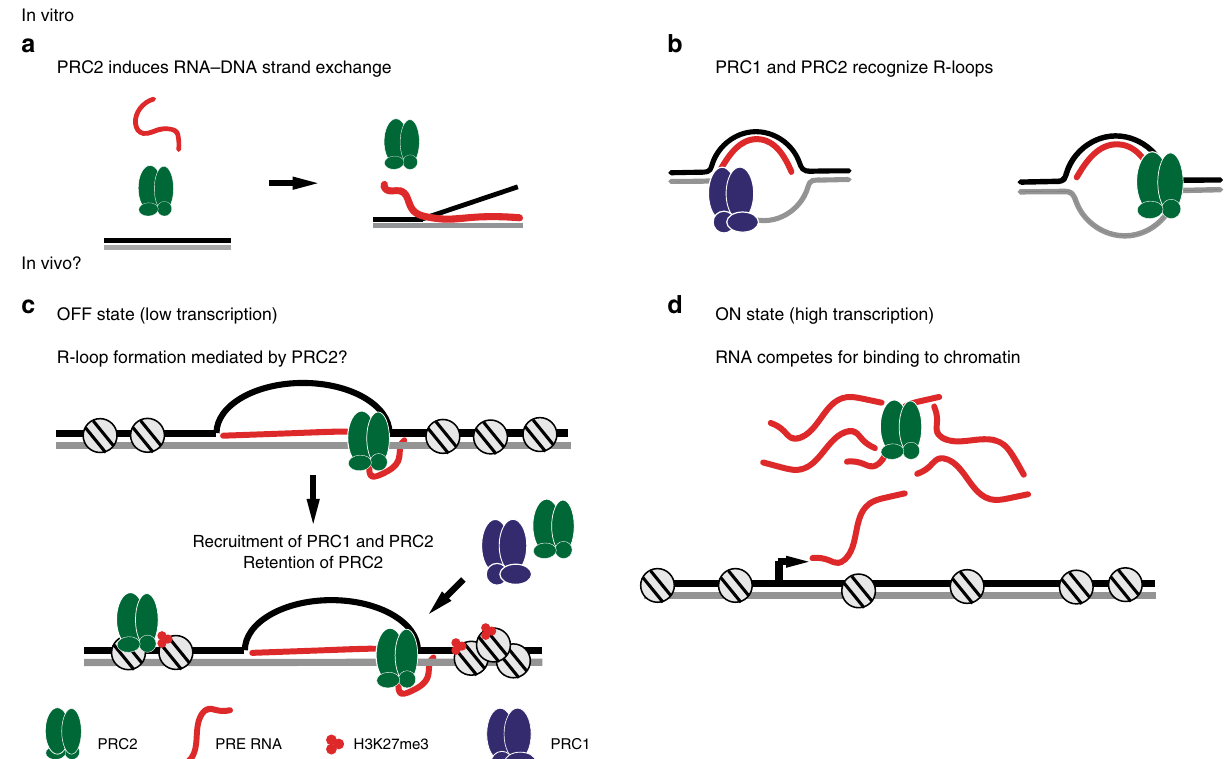
Fig. 7 Model for the role of R-loop formation driven by PRC2 in PcG gene silencing. Top panels ( a , b ) summarize our in vitro results with PRC2 ( a , b ) and PRC1 ( b ). Bottom panels ( c , d ) are a speculative model for how these activities could contribute to establishing or maintaining the OFF state at PREs. The ability of RNA to compete for PRC2 binding to chromatin is based on extensive observations in the literature. a PRC2 mediates RNA – DNA strand exchange, creating RNA – DNA hybrids. b PRC1 and PRC2 recognize R-loops. c Low levels of transcription through PREs could allow R-loop formation, which could depend on PRC2 activity (but could also be independent). R-loop formation sequesters the RNA and inhibits new RNA production, allowing PRC2 to be retained on chromatin. Recruitment of PRC1 and PRC2 (and other factors) may occur through recognition of the R-loop. d RNA produced by high levels of transcription competes for PRC2 binding to chromatin. See Discussion for details. This model is inspired by that of Ringrose 12 , but incorporates our new in vitro